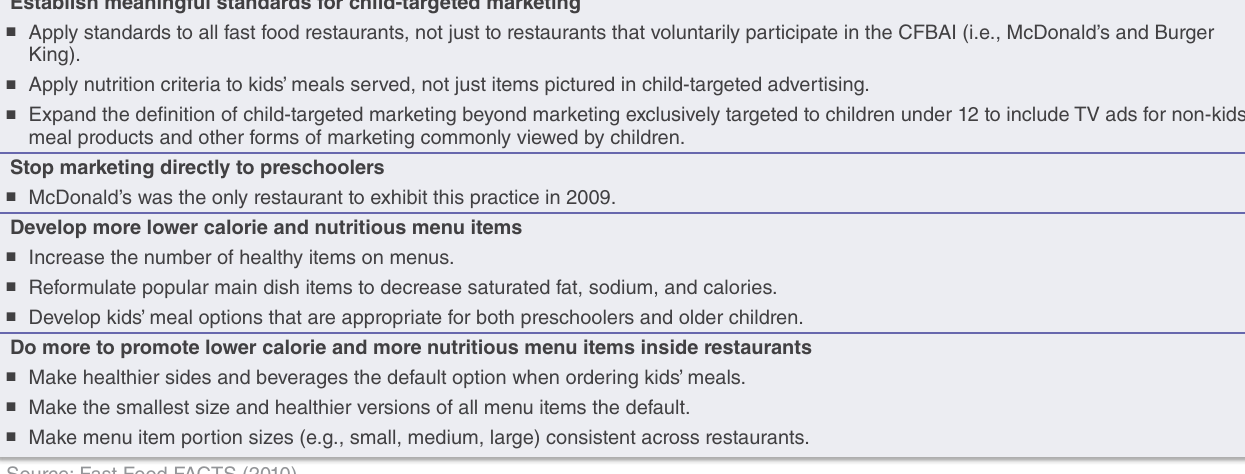
Table 2. Fast Food FACTS 2010: Recommendations Establish meaningful standards for child-targeted